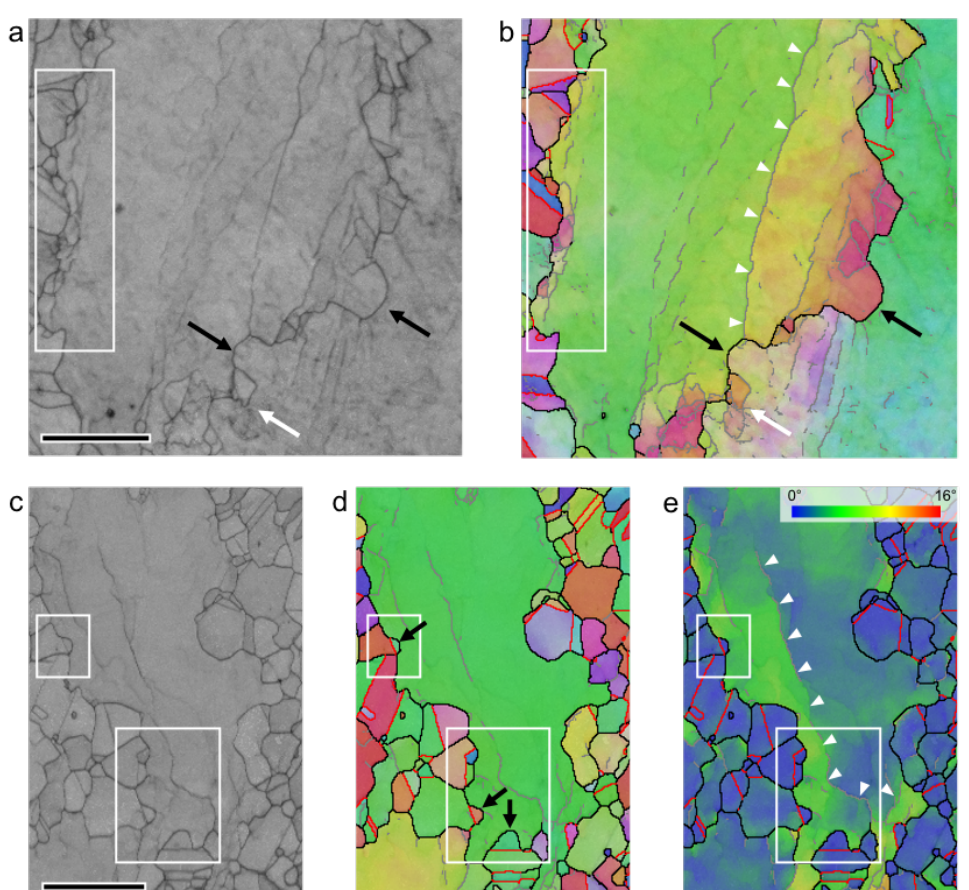
Figure 15. Nucleation of DRX grains. ( a ) Band contrast and ( b ) IPF maps from a sample deformed at 1080 ◦ C and 0.05 s − 1 , showing bulging grain boundaries (black arrows) and misoriented subgrains along grain boundaries (white arrow and white rectangle). A long low angle boundary with misorientation in the range 5–7 ◦ is indicated by multiple white arrowheads in ( b ). ( c ) Band contrast, ( d ) IPF and ( e ) grain reference orientation deviation (GROD) maps from same sample as in ( a ), showing “cutting off” of DRX grains by twinning (red lines in the white rectangles, also marked with black arrows in ( d ), and concentration of deformation along grain boundary (multiple white arrowheads in ( e ). Scale bar is 20 µ